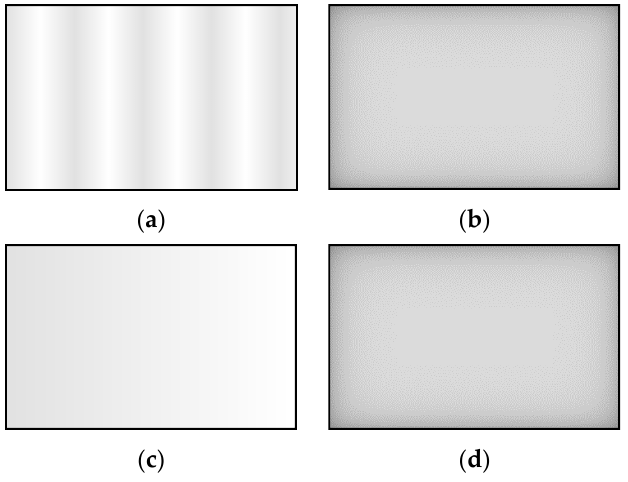
Figure 7. High saturated pixel slope (SPS) overall vs. Low SPS overall . ( a ) High SPS overall original image; ( b ) High SPS overall image after excessive dimming; ( c ) Low SPS overall original image; ( d ) Low SPS overall image after excessive dimming.